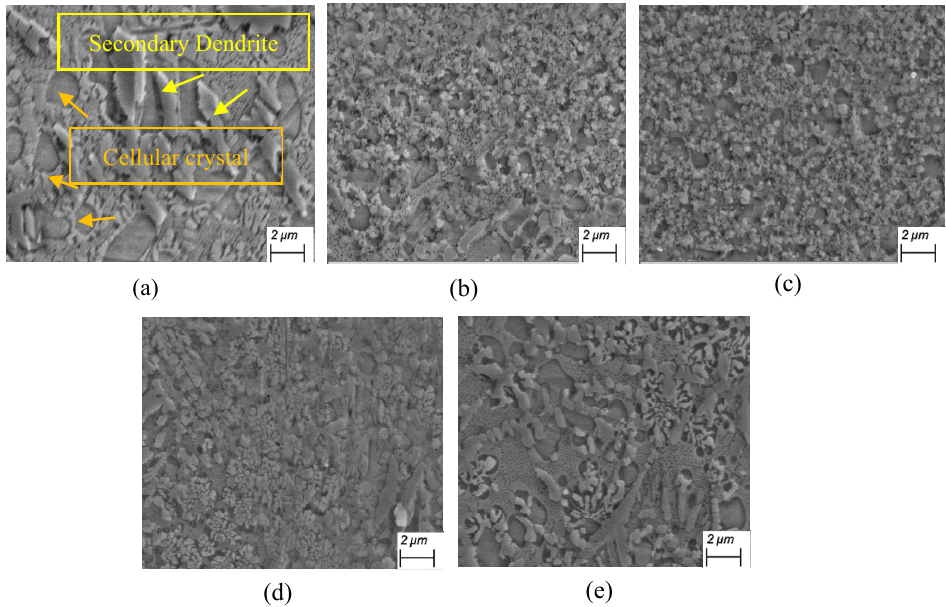
Figure 4. SEM pictures of the top layer (Ni60) under different ultrasonic frequencies. ( a ) 0; ( b ) 26 kHz; ( c ) 30 kHz; ( d ) 34 kHz; ( e ) 38 kHz.